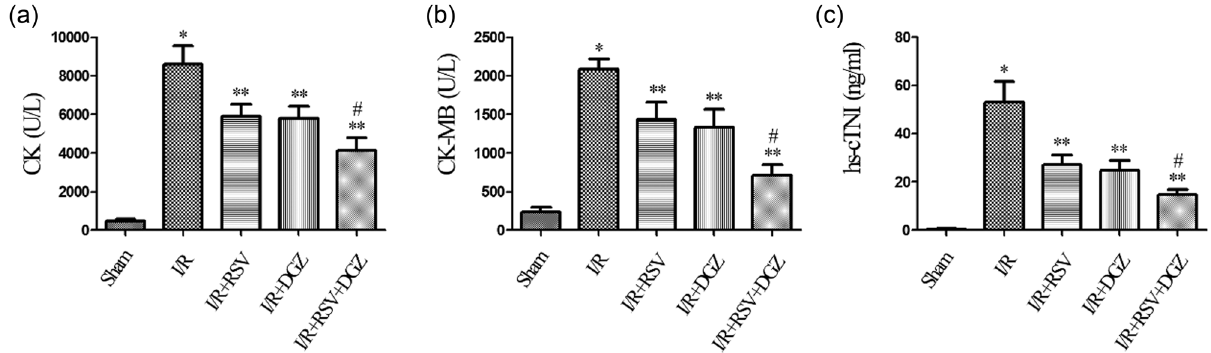
Figure 2: Comparison of the serum CK, CK - MB, and hs - cTNI levels across various experimental groups of SD rats ( mean ± SD, n = 5 ) . * p < 0.001 compared with Sham; ** p < 0.05 compared with I/R; # p < 0.05 compared with I/R + RSV or I/R + DGZ. Sham: sham operated group; I/R: ischemia/reperfusion group; I/R + RSV: ischemia/reperfusion + rosuvastatin group; I/R + DGZ: ischemia/reperfusion +